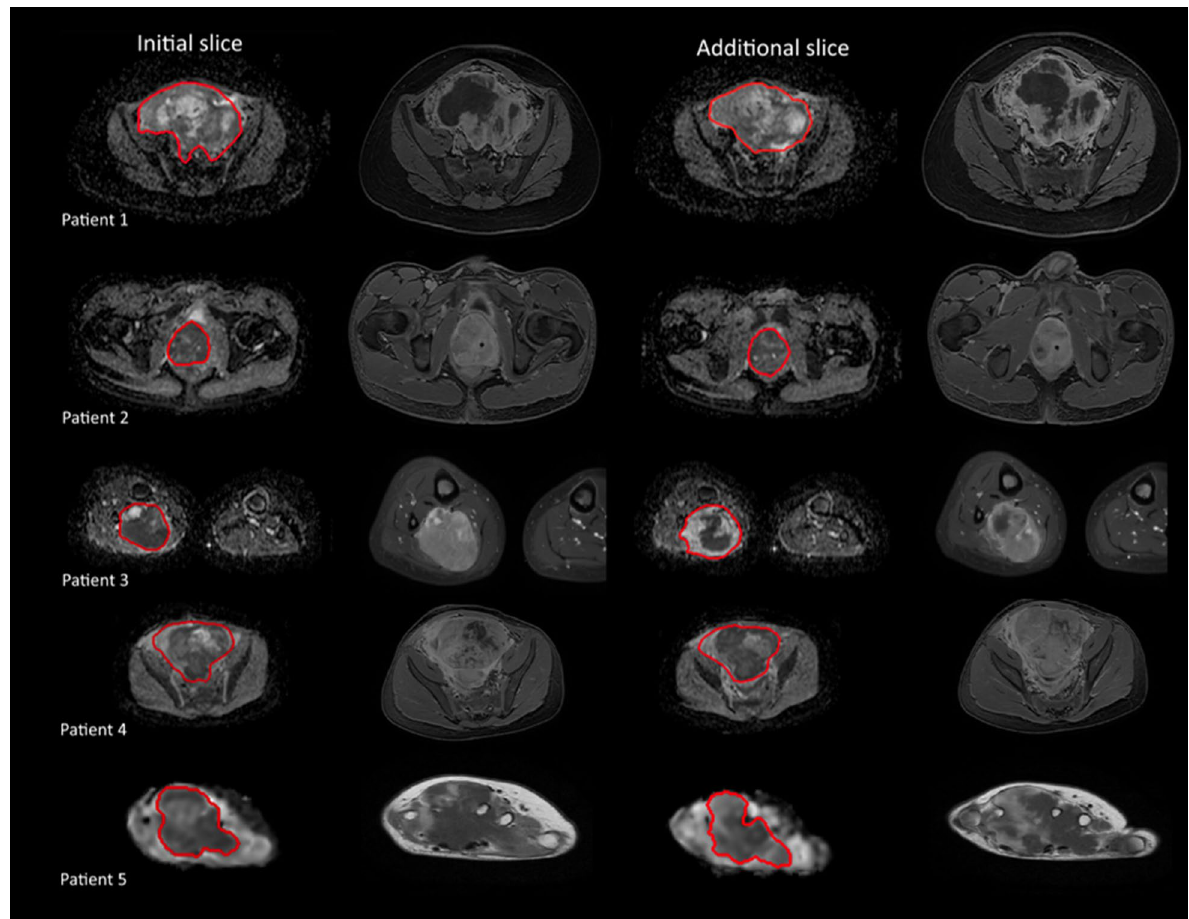
Fig. 3 Apparent diffusion coefficient (ADC) maps and T1 post-contrast images for both the initial slice (columns 1 and 2) and the additional slice (columns 3 and 4) where segmentations have been made. The ADC maps include the outline of segmentation strategy 1 as described in Results